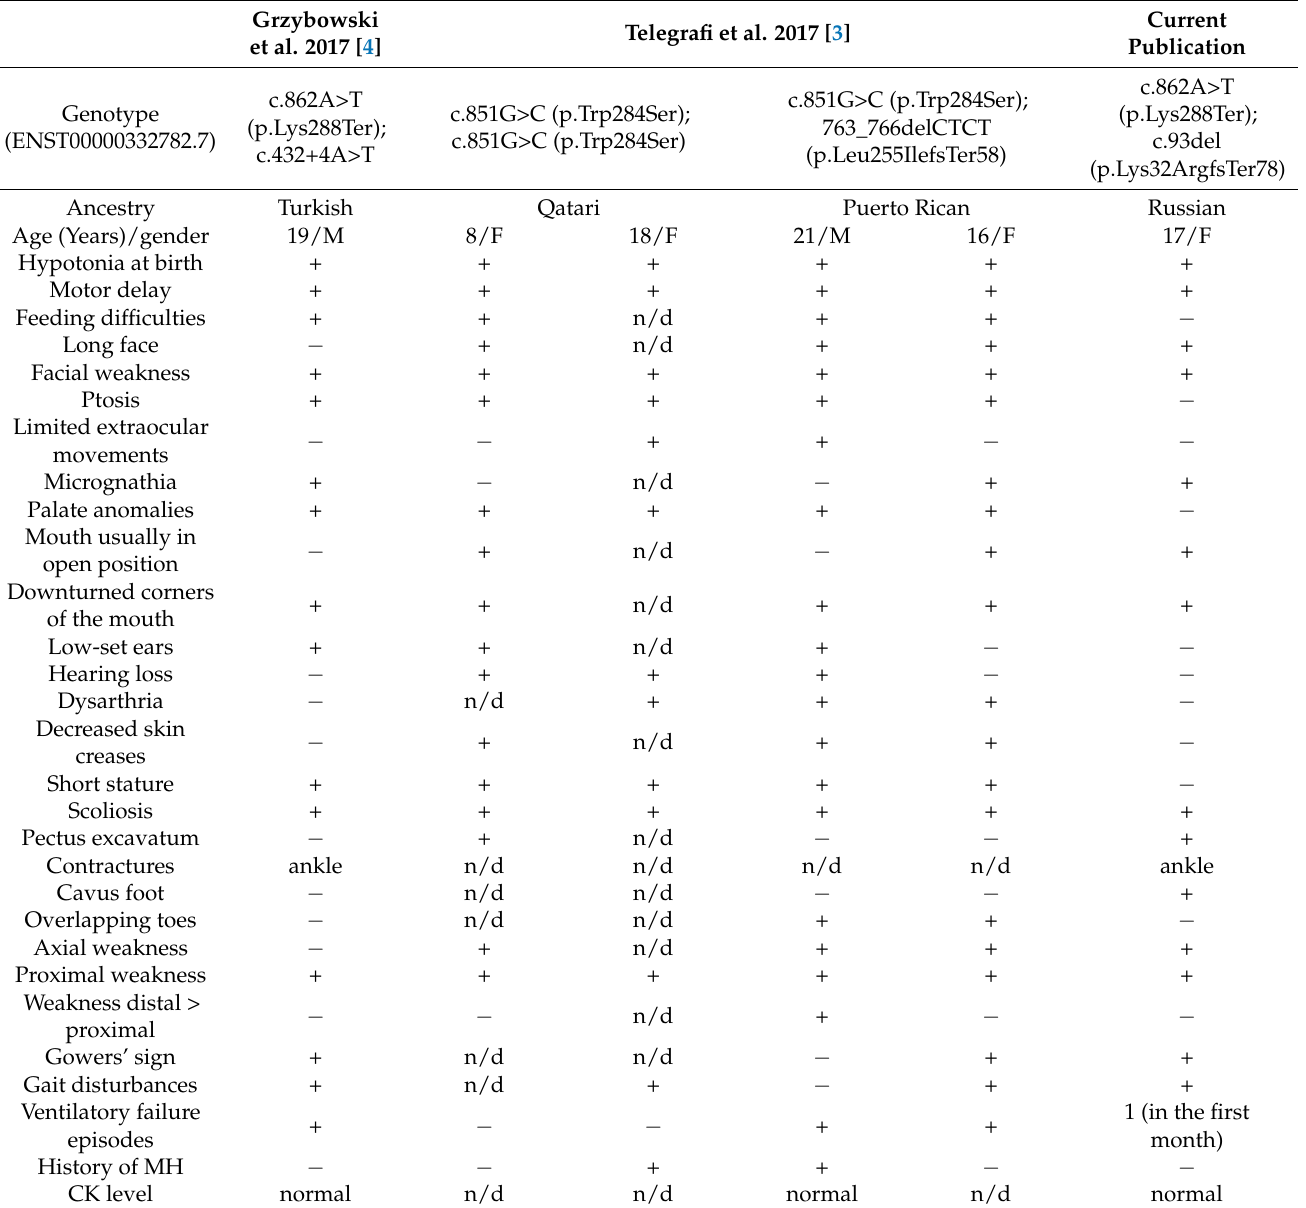
Table 1. Clinical features of non-Amerindian patients with STAC3